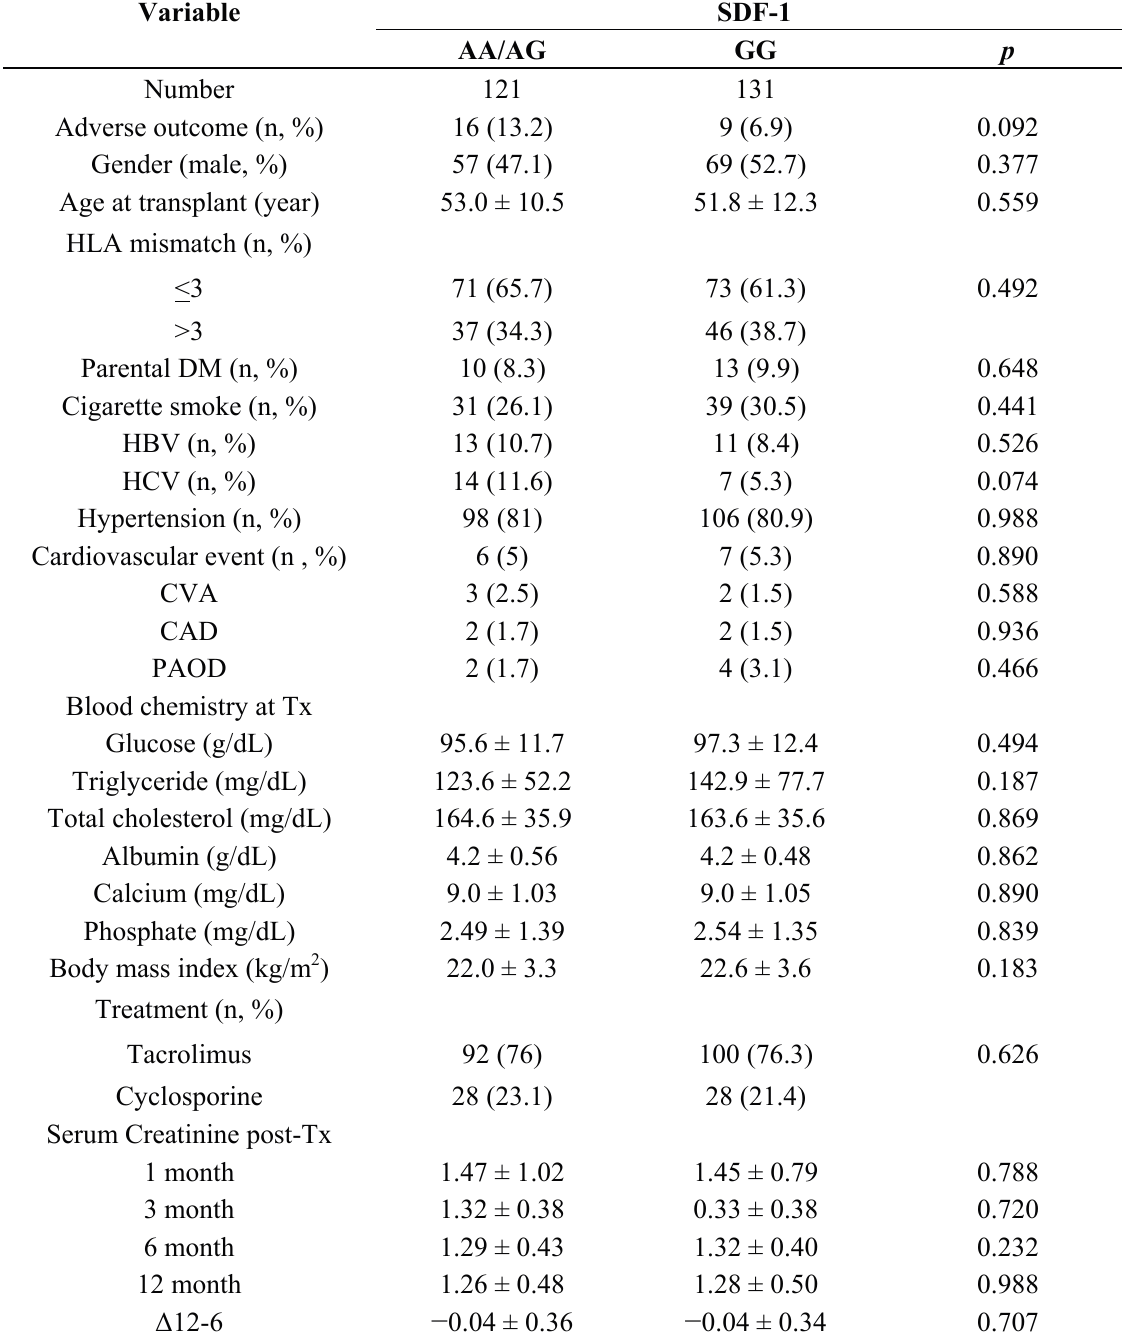
Table 1. Baseline characteristics of patients with SDF-1 AA/AG or GG